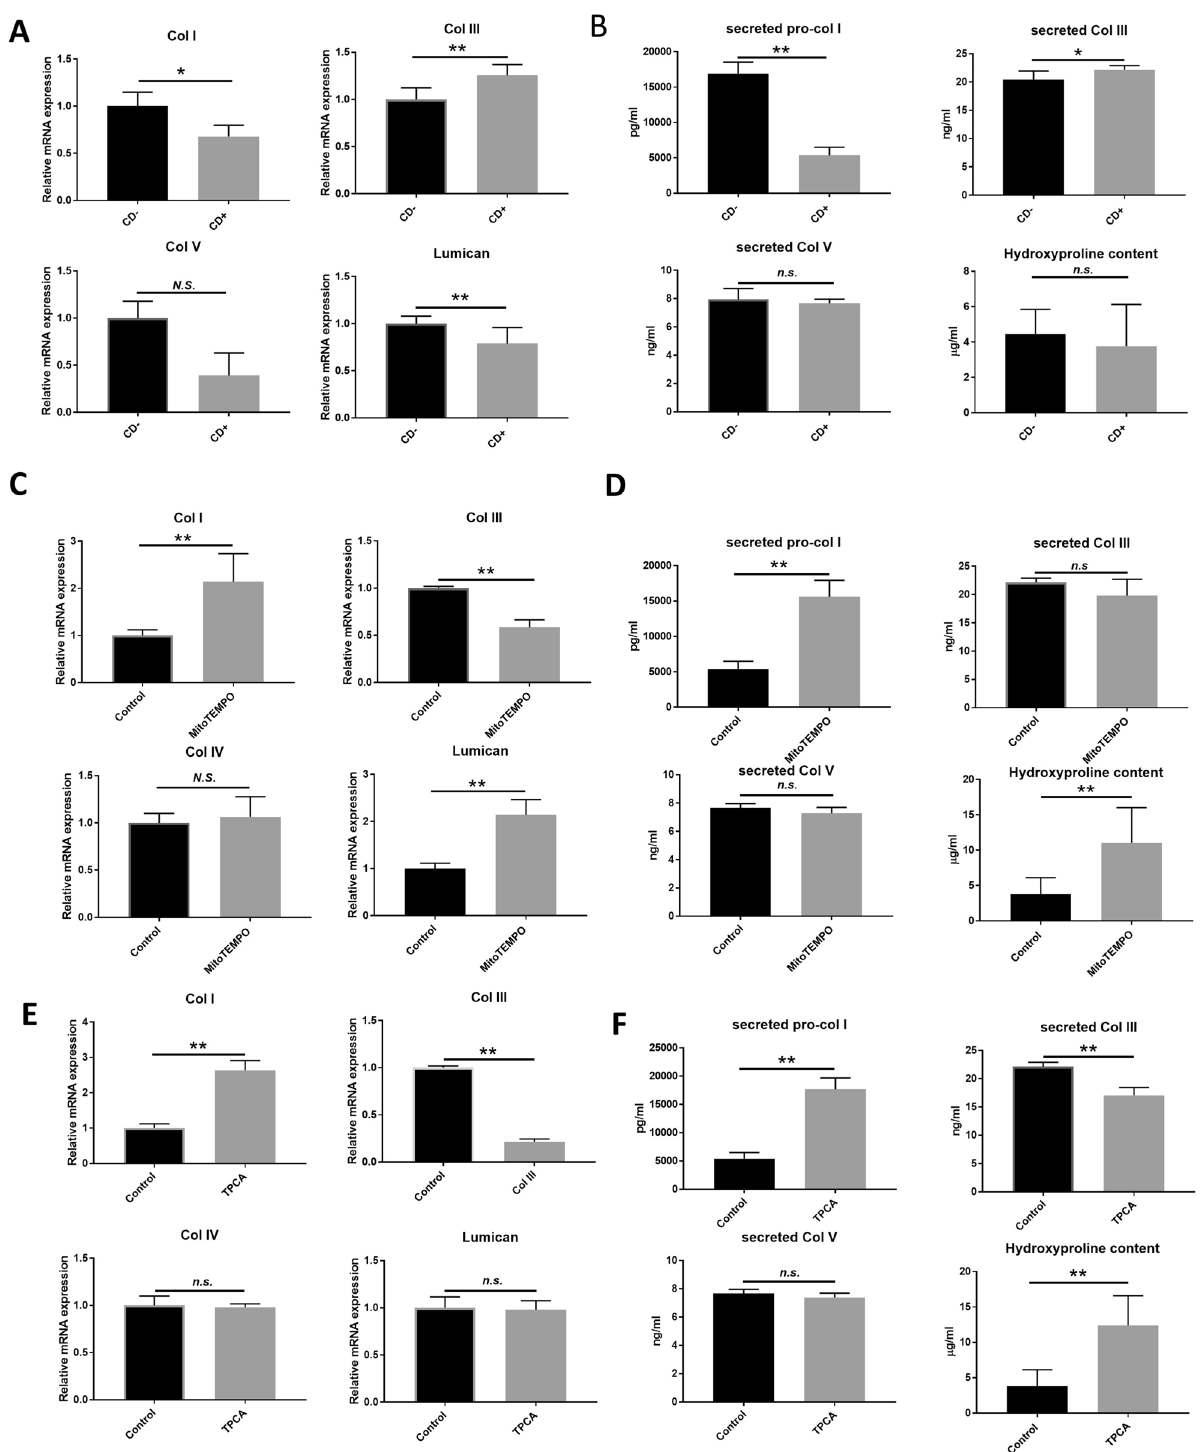
Figure 4. Changes in various ECM components in corneal myofibroblasts are dependent on mitochondrial ROS and NF-κB signaling. ( A ) RT qPCR on the mRNA expression of COL1A1, COL3A1, COL5A1 and lumican in corneal myofibroblasts ( n = 3). ( B ) Secretion of pro-collagen I, collagen III, collagen V, and hydroxyproline content in supernatant collected 2 d after fibrosis induction ( n = 3). ( C ) RT qPCR of the mRNA expression of COL1A1, COL3A1, COL5A1 and lumican in CD+ corneal myofibroblasts. Cells were treated with 10 µM mitoTEMPO for 2 d ( n = 3). ( D ) Secretion of pro-collagen I, collagen III, collagen V, and hydroxyproline content in supernatant collected 2 d after fibrosis induction in CD+ myofibroblasts simultaneously treated with 10 µM mitoTEMPO ( n = 3). ( E ) RT qPCR of the mRNA expression of COL1A1, COL3A1, COL5A1 and lumican in CD+ corneal myofibroblasts treated with 20 nM TPCA for 48 h ( n = 3). ( F ) Secretion of pro-collagen I, collagen III, collagen V, and hydroxyproline content in supernatant collected 2 days after fibrosis induction in CD+ myofibroblasts simultaneously treated with 20 nM TPCA ( n = 3). Values are means ± SD. n.s. (not significant); *P < 0.05, **P <